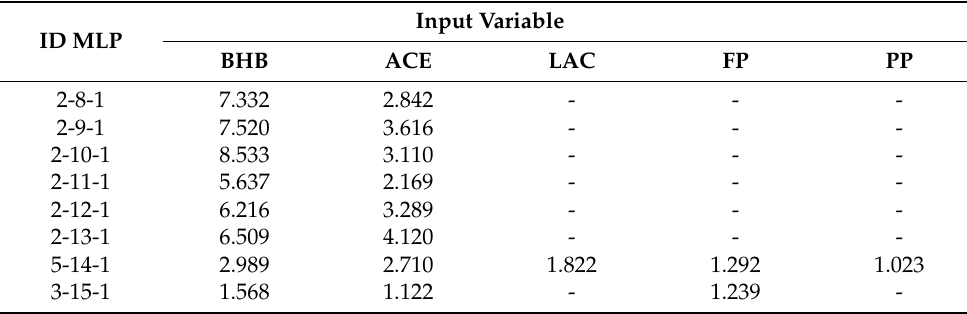
Table 5. Network sensitivity analysis for